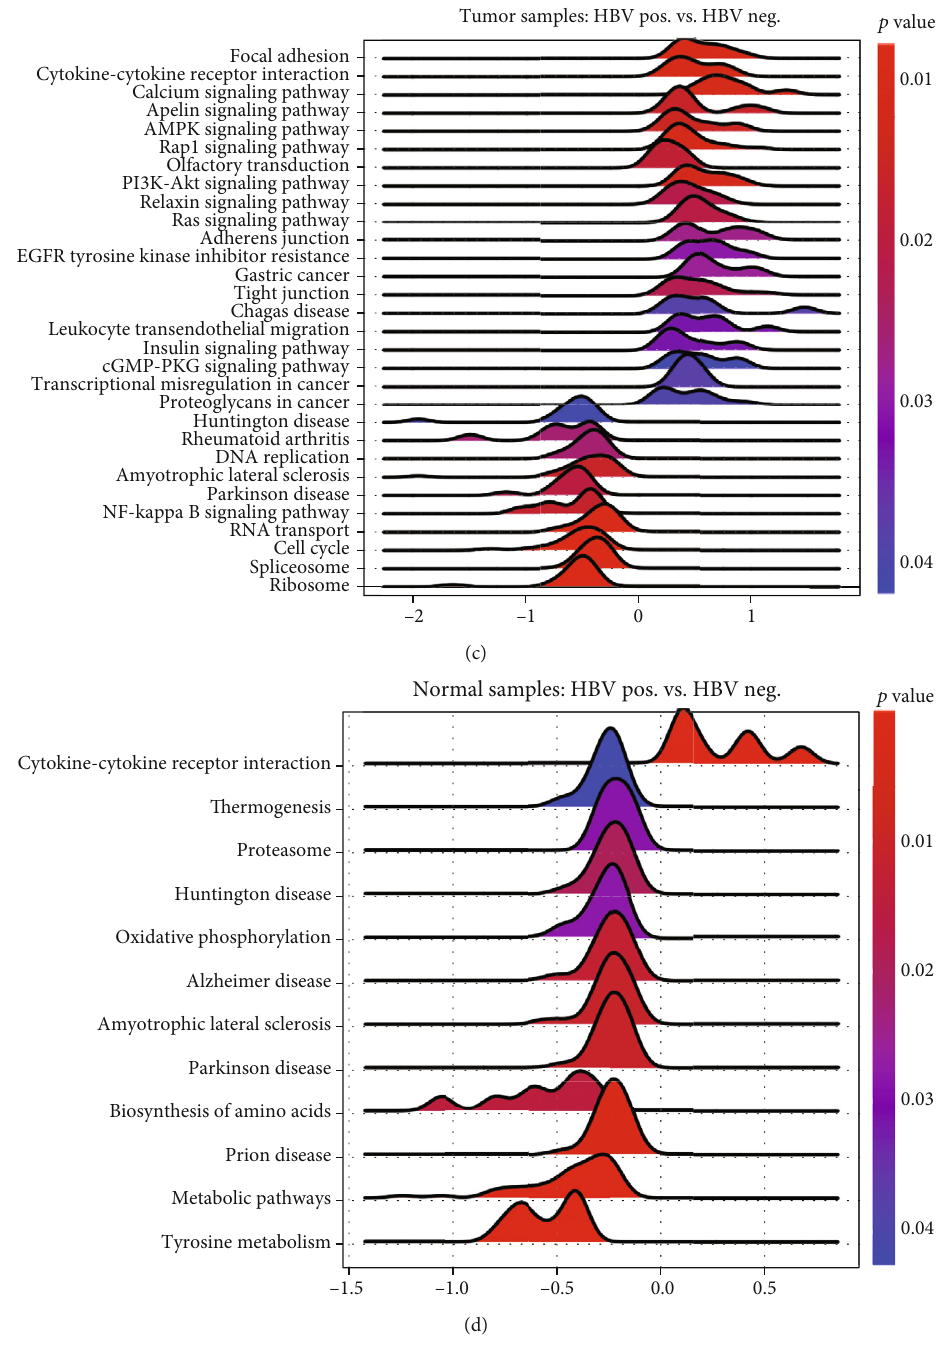
Figure 1: HBV infection-related genes were associated with increased in fl ammation and several oncogenic signaling pathways. (a, b) Heat map of all signi fi cantly di ff erently expression genes (DEGs) ( n = 964 , HBV Pos. vs. HBV Neg, in tumor tissues, and n = 1098 , HBV Pos. vs. HBV Neg. in normal tissues). (c, d) GSEA results obtained by using DEGs by comparing between HBV Pos. and HBV Neg. Samples in tumor (c) and normal (d)